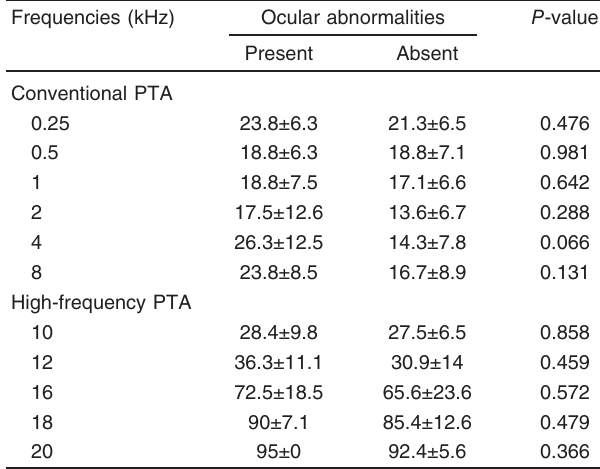
Table 9 Comparison between results of pure-tone audiometry (conventional and extended high frequency) in vitiligo patients according to their ocular